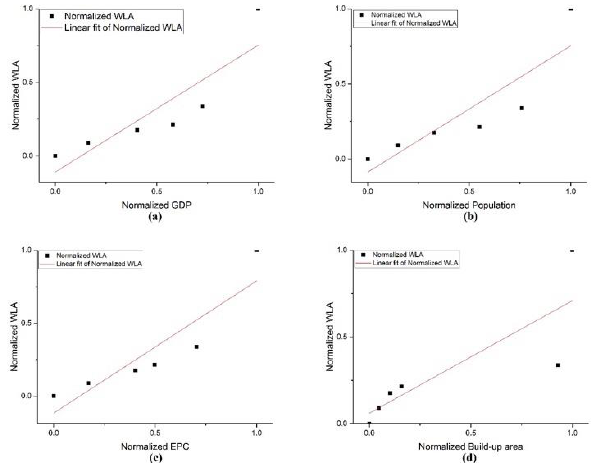
Figure 4. Linear response of DMSP/OLS NTL signals shown as normalized WLA and a) normalized GPD; b) normalized population; c) normalized EPC; d) normalized built-up area After normalization, the four urbanization variables and WLA are plot over the years to explore their trends (Figure 5). The four variables as well as WLA increases over time. GDP, population increases significantly in 2008 and 2009, respectively.